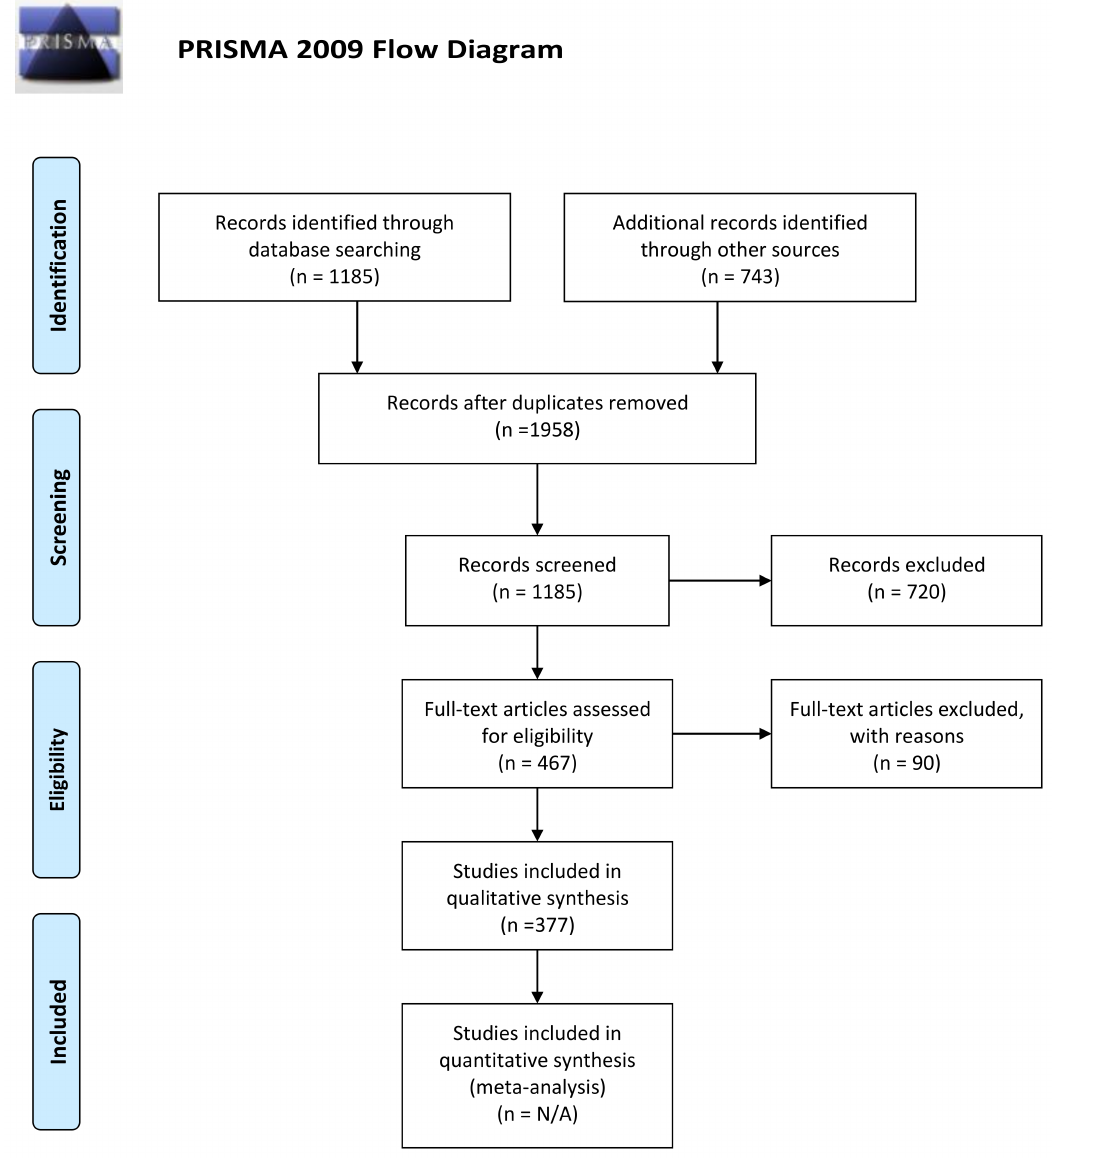
Figure 1. Lyme disease causing psychiatric illness